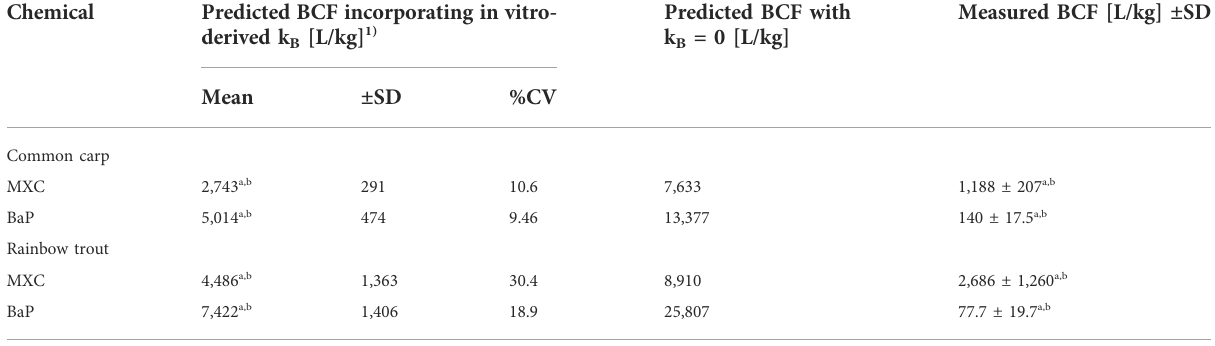
TABLE 4 Comparison of predicted and measured bioconcentration factor (BCF) values of methoxychlor (MXC) and benzo[a]pyrene (BaP) in common carp and rainbow